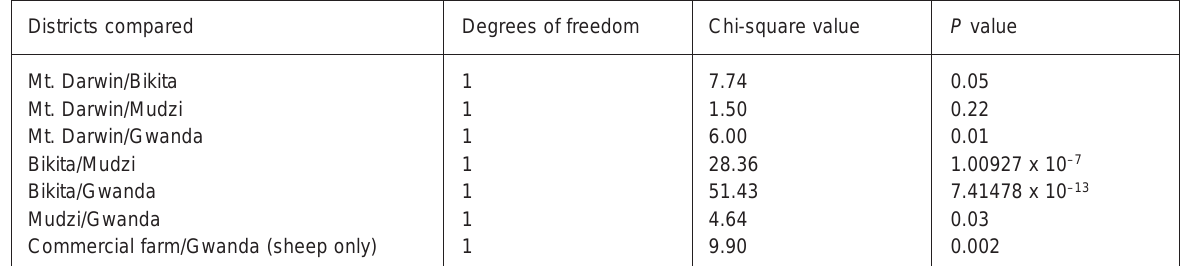
TABLE 3 Comparison of Toxoplasma gondii seropositivity rates in small ruminants from different communal land districts using the